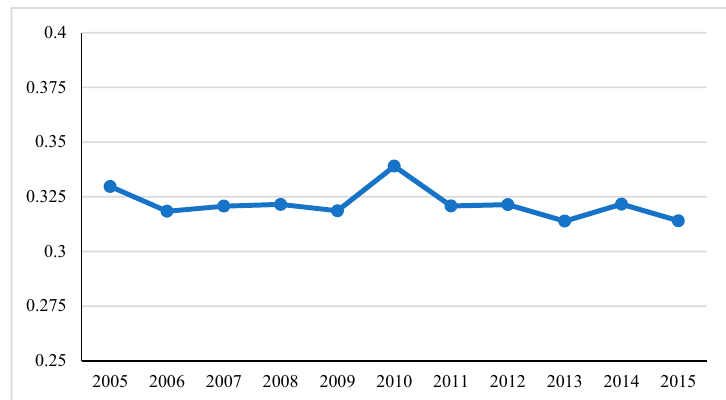
Figure 6. Index of spatial difference in urbanization coordination level from 2005 to 2015.